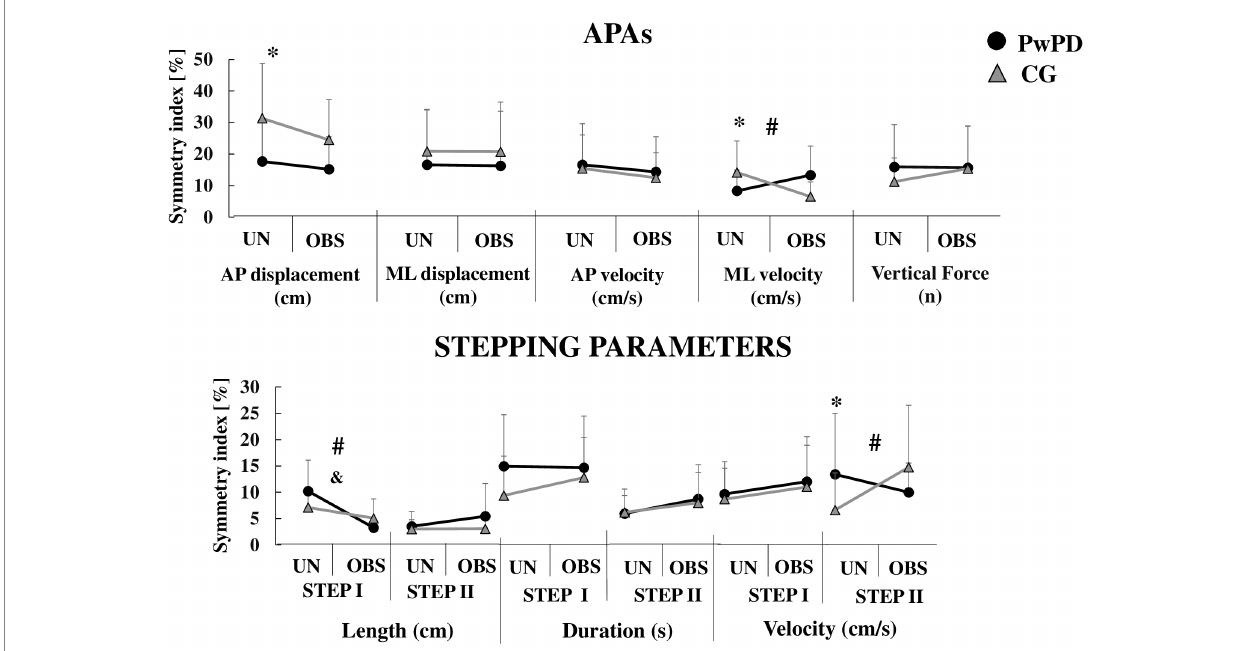
FIGURE 2 Means and standard deviations of the APAs and stepping parameters symmetry index during unobstructed (UN) and obstructed (OBS) GI in PwPD and CG. *: Significant main effect of group; &: Significant main effect of GI condition; #: Significant group by condition interaction. For clarity, the symbol for a significant main effect of group (*) is located on the left of each sub-figure, where the unobstructed data is presented.